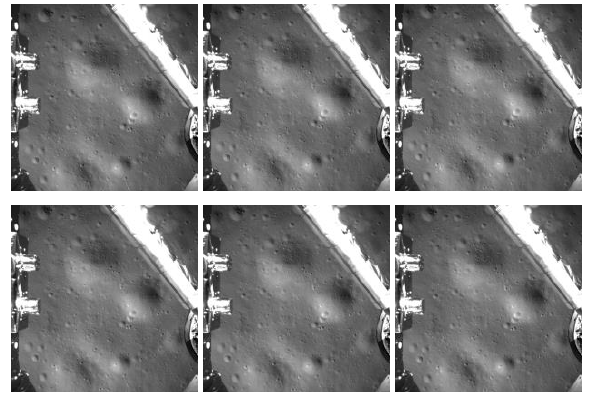
Figure 3. The sub-sequential of descent images The interval time of these images were mainly 1s. Feature extraction and matching were implemented with SIFT not only between adjacent images, but also in sequential images. Figure 4 shows the matching results between 1 st image and 2 nd , 3 rd ,4 th image of the selected image sequence.